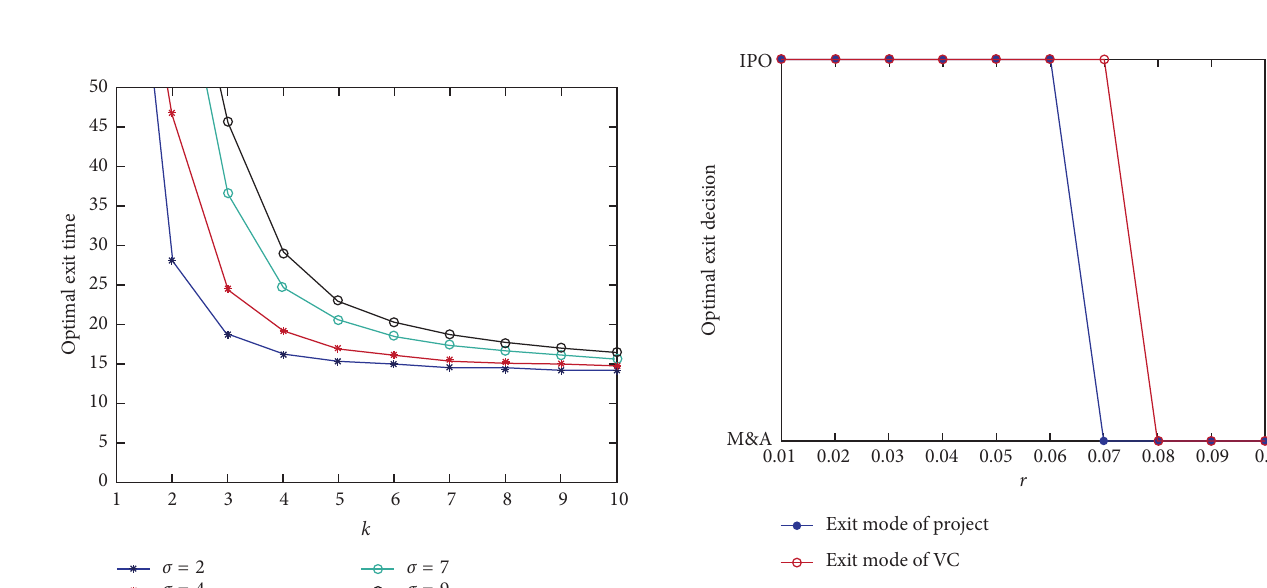
Figure 8: Optimal exit decision ( σ � 9 ) .